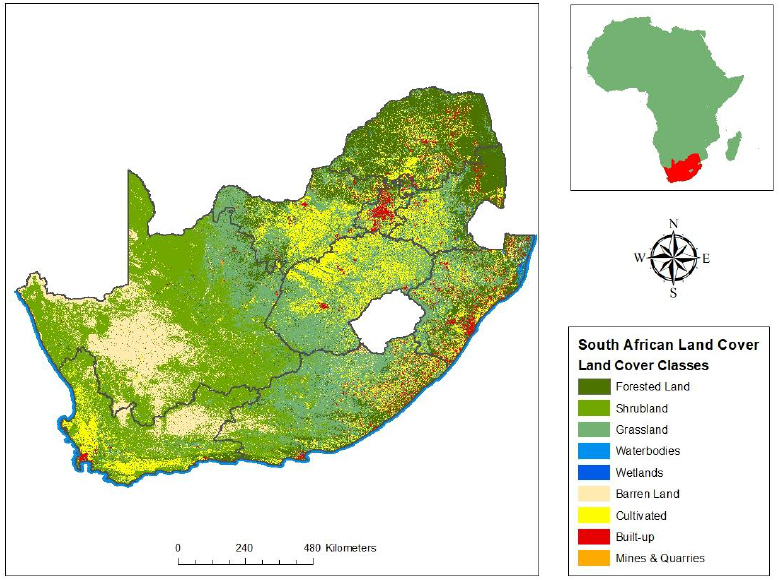
Figure 1. Land Cover map of South Africa. The data was retrieved from the South African Department of Forestry, Fisheries and the Environment. (https://egis.environment.gov.za/data_egis/data_download/current, last accessed on 15 November 2022).